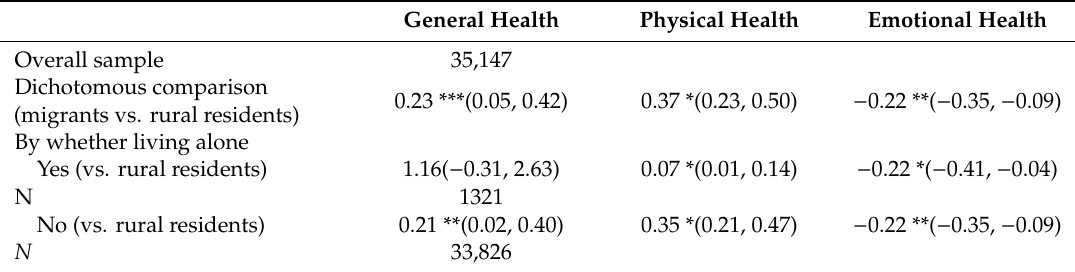
Table 3. Marginal e ff ects of migration status by whether living